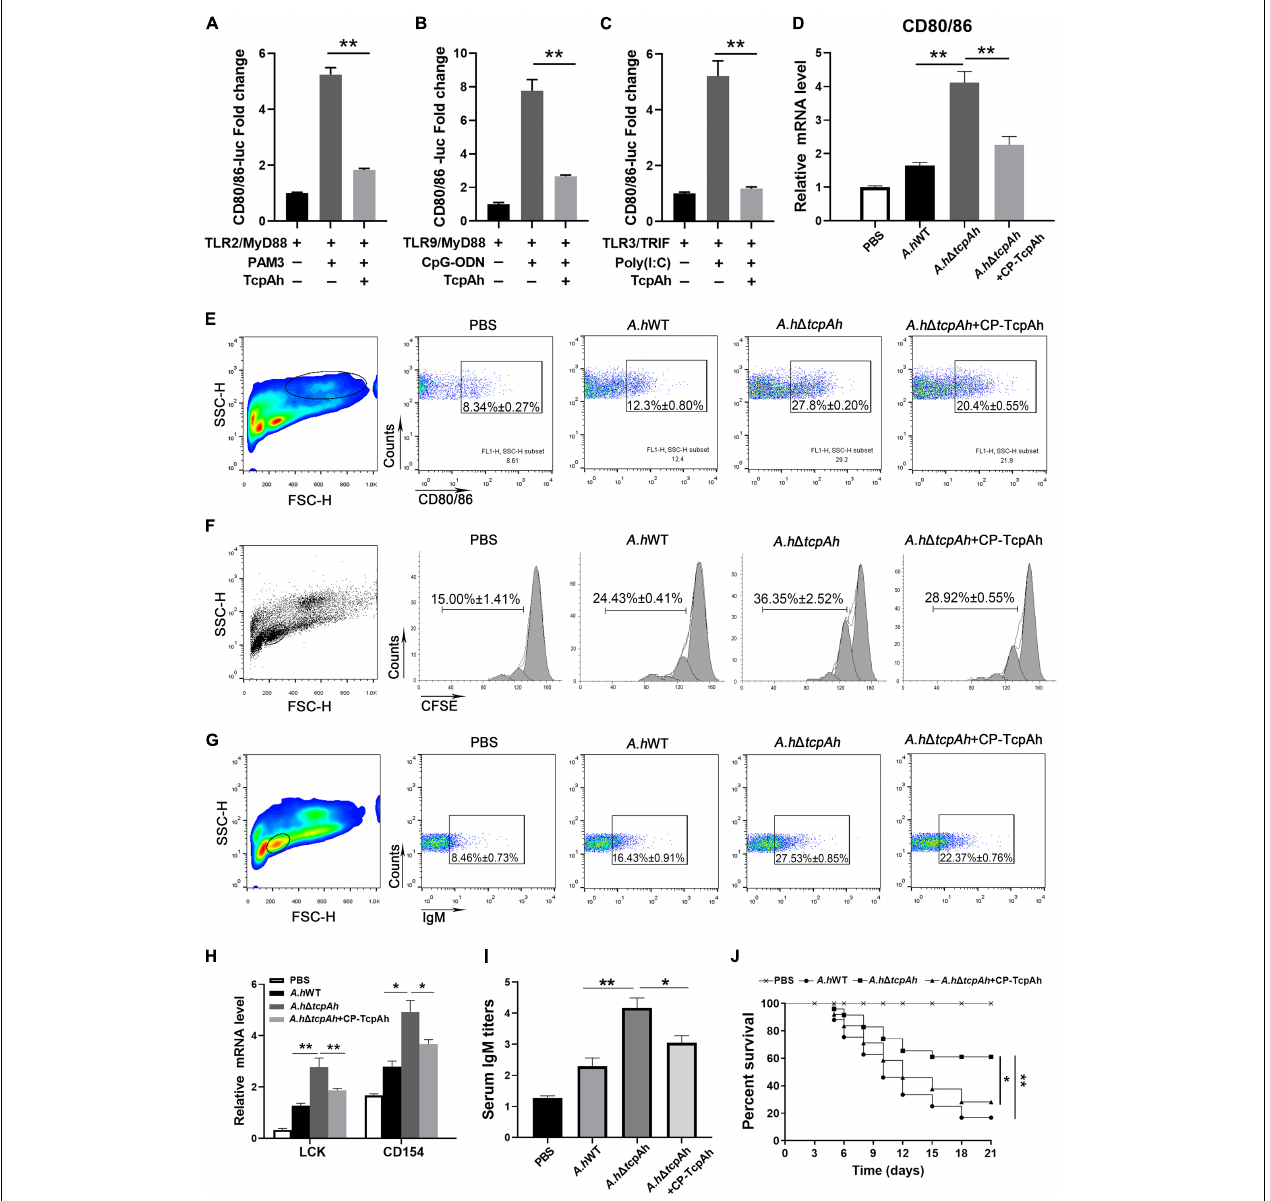
FIGURE 8 | Examination of the inhibitory role of TcpAh in zebrafish adaptive humoral immunity against infection by repressing CD80/86 expression. (A–C) Activation of zebrafish CD80/86 promoter in HEK293T cells transfected with CD80/86 luciferase reporter (CD80/86-Luc; 200 ng/mL), renilla luciferase reporter (15 ng/mL) and expression vectors for zebrafish TLR2 or TLR9 or TLR3 (20 ng/mL) in combination with MyD88 or TRIF (20 ng/mL) with or without TcpAh expression vector (250 ng/mL). After 24 h, the HEK293T cells were stimulated with PAM3 or CpG-ODN or Poly(I:C) for 12 h. Data are the average luciferase activity ± SD (** p < 0.01; *** p < 0.001). (D) Real-time PCR analysis for the expression of zebrafish cd80/86 in leukocytes, which were sorted from peripheral blood, spleen, and kidney tissues 2 days after i.p. stimulation with PBS, wild-type A. hydrophila , (cid:49) tcpAh mutant, or (cid:49) tcpAh mutant complemented with CP-TcpAh protein. Data are representative of three independent experiments as mean ± SD (* p < 0.05; ** p < 0.01). (E) Flow cytometric analysis of CD80/86 expression level on MHC-II + antigen-presenting cells (APCs) of each in vivo treatment group. Data are representative of three independent experiments as mean ± SD (* p < 0.05; ** p < 0.01). (F) Proliferation of lymphocytes determined by CFSE dilution through flow cytometry under the indicated experimental treatment. (G) Proliferation of IgM + B cells determined by flow cytometry under the indicated experimental treatment. Data are representative of three independent experiments as mean ± SD (* p < 0.05; ** p < 0.01). (H) Real-time PCR analysis of the expression levels of zebrafish LCK and CD154 of each in vitro treatment group. Data are representative of three independent experiments as mean ± SD (* p < 0.05; ** p < 0.01). (I) Examination of the inhibitory role of TcpAh in IgM production in response to A . hydrophila infection in each treatment group by ELISA. Data are representative of three independent experiments as mean ± SD (n = 20; * p < 0.05; ** p < 0.01). (J) Examination of the inhibitory role of TcpAh in zebrafish defense against A . hydrophila infection. Zebrafish were infected with A . hydrophila (cid:49) tcpAh or with wild-type A . hydrophila or with A . hydrophila (cid:49) tcpAh complement with CP-TcpAh. Differences were analyzed using log-rank test (* p < 0.05; ** p < 0.01). Group of fish injected with mock PBS was used as a negative control.